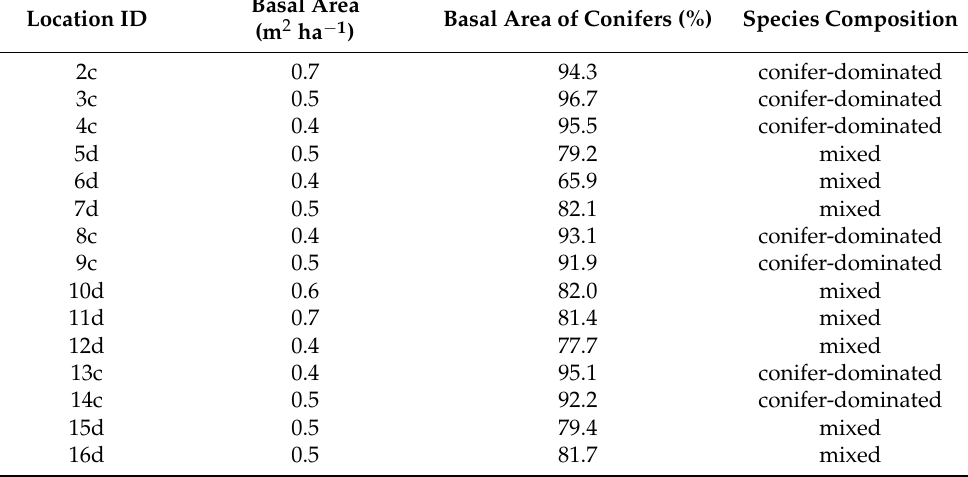
Table 1. Species composition in the 10-m surroundings of the 16 sensor locations (for measure- ments of transmitted PAR). The small letters in the column “location ID” indicate spruce-dominated (coniferous, “c”) or mixed (coniferous–deciduous, “d”) species compositions. Basal Area Basal Area of Conifers (%) Species Composition Location ID (m 2 ha − 1 ) 2c 0.7 94.3 conifer-dominated 0.5 96.7